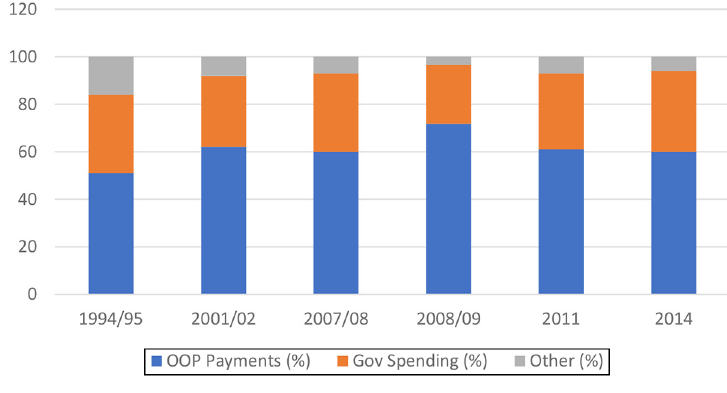
Figure 3. Shares of payment sources in